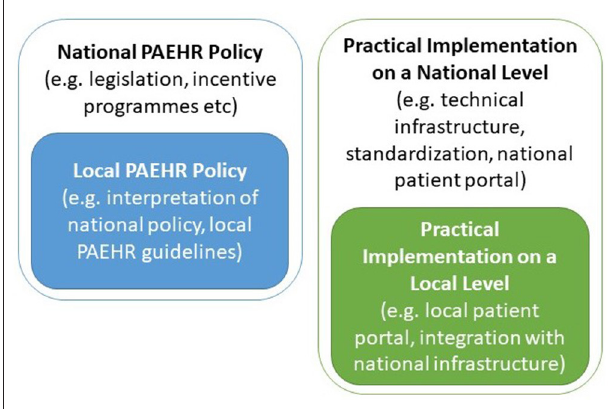
FIGURE 1 | Components of patient-accessible electronic health record implementation.